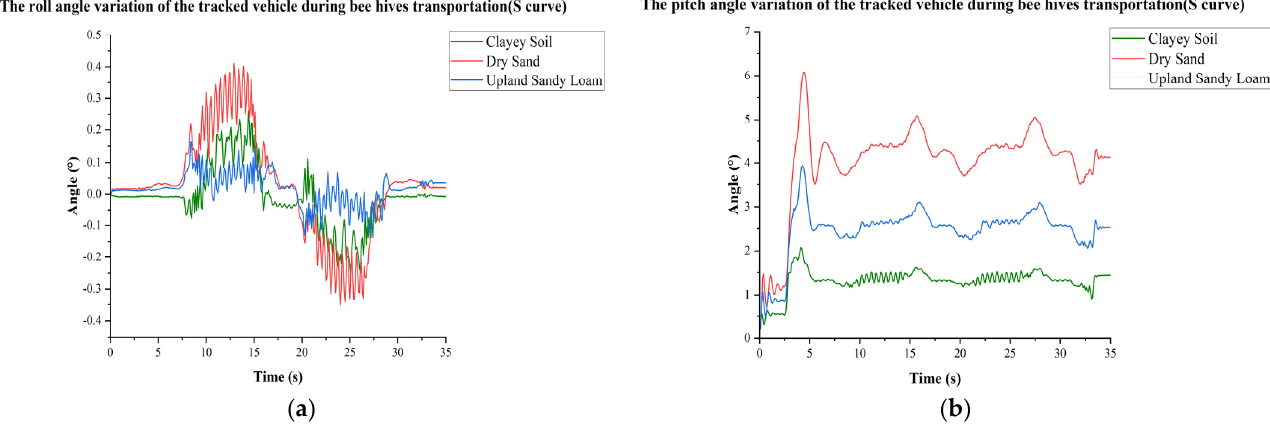
Figure 24. Variation of ( a ) roll values under each pavement condition when the vehicle is fully loaded with beehives (s-turn) and ( b ) pitch values under each pavement condition when the vehicle is fully loaded with beehives (s-turn).